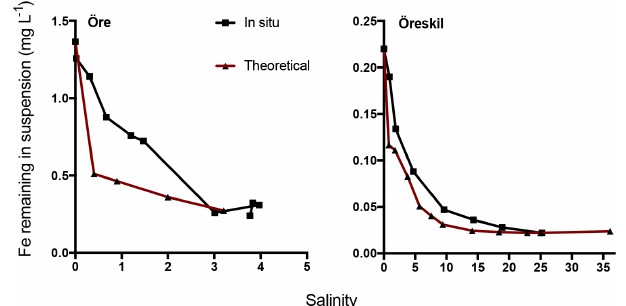
Figure 6. Fe concentration in suspension at different salinities. The black line denotes in situ samples along a transect from the river mouth and the brown line theoretical values based on mixing exper-